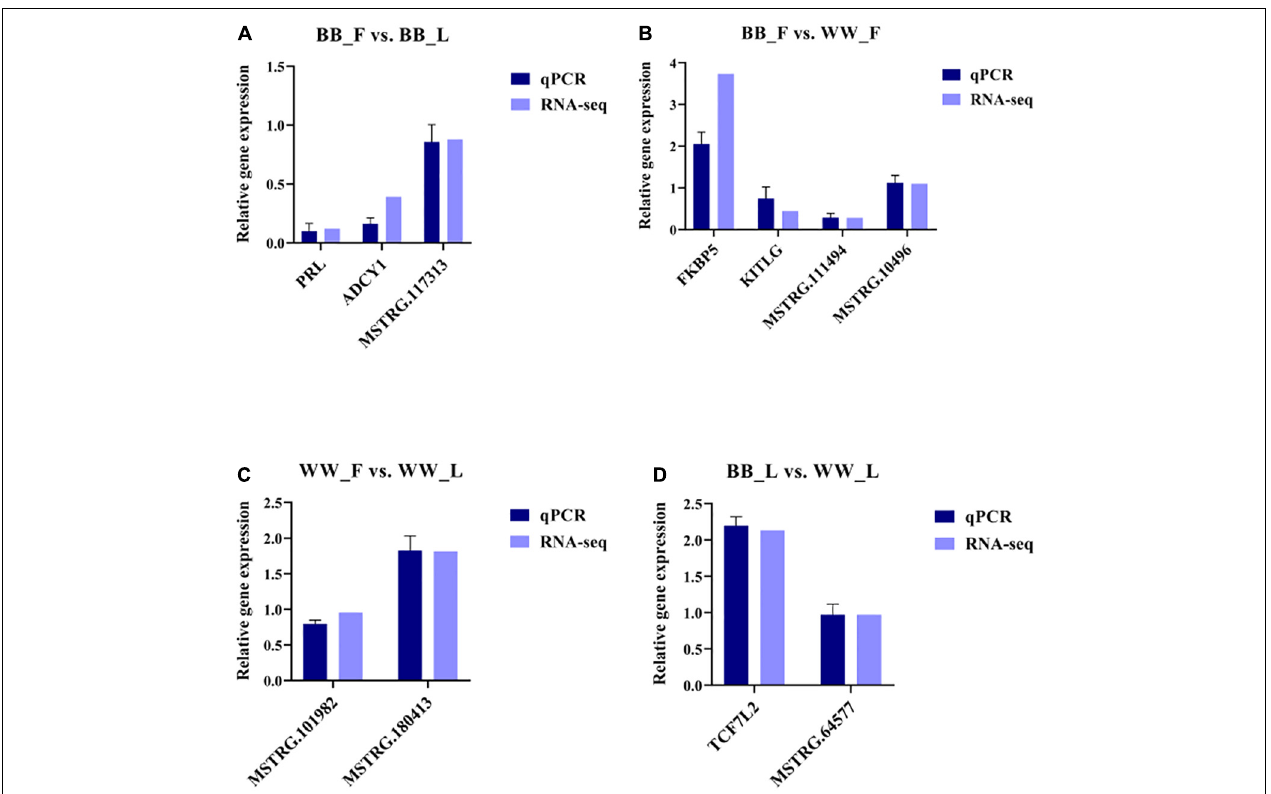
FIGURE 5 | Validation of RNA-seq data by RT-qPCR. RT-qPCR and RNA-seq data are presented as relative gene expression. (A) Selected genes and lncRNAs from BB_F vs. BB_L are validated by RT-qPCR and RNA-seq, respectively. (B) Selected genes and lncRNAs from BB_F vs. WW_F are validated by RT-qPCR and RNA-seq, respectively. (C) Selected genes and lncRNAs from WW_F vs. WW_L are validated by RT-qPCR and RNA-seq, respectively. (D) Selected genes and lncRNAs from BB_F vs. WW_L are validated by RT-qPCR and RNA-seq,